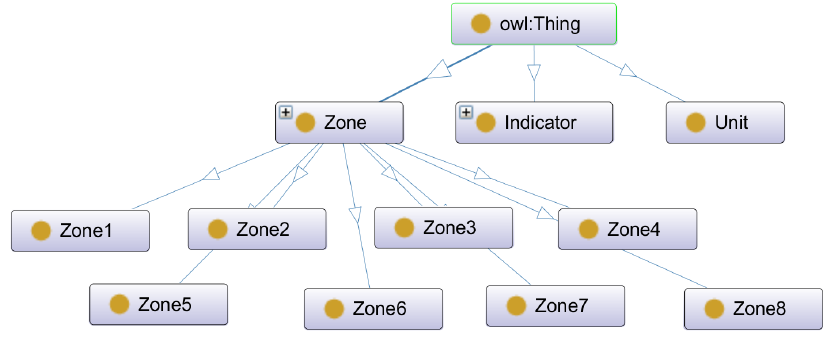
Figure 2. Main classes of the water Ontology. Arrows refer to subClassOf.